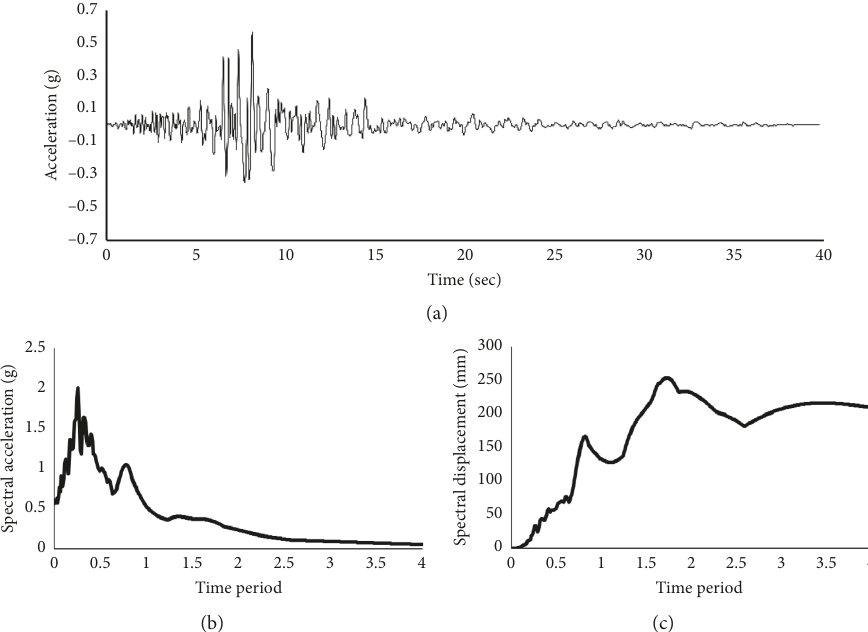
Figure 3: Selected earthquake record for shake table tests. (a) Northridge 1994 acceleration time history. (b) 5% damped acceleration response spectra. (c) 5% damped displacement response spectra.